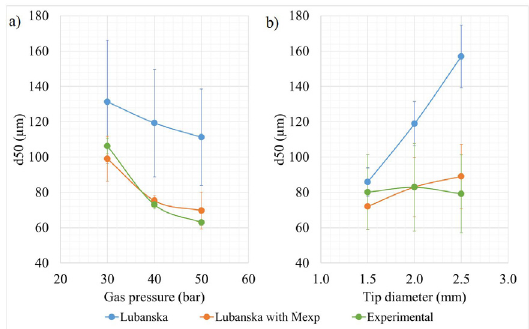
Figure 6. Median particle size calculated using the mathematical model, calculated with the experimental metal flow rate and experimental d50 as a function of the a) gas pressure and b) tip